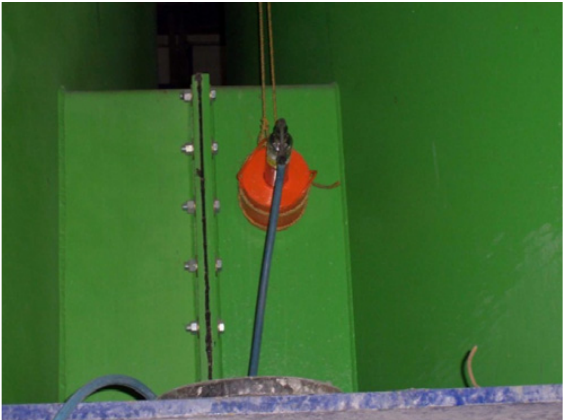
Figure 4. Sensor located on cell tailings connection